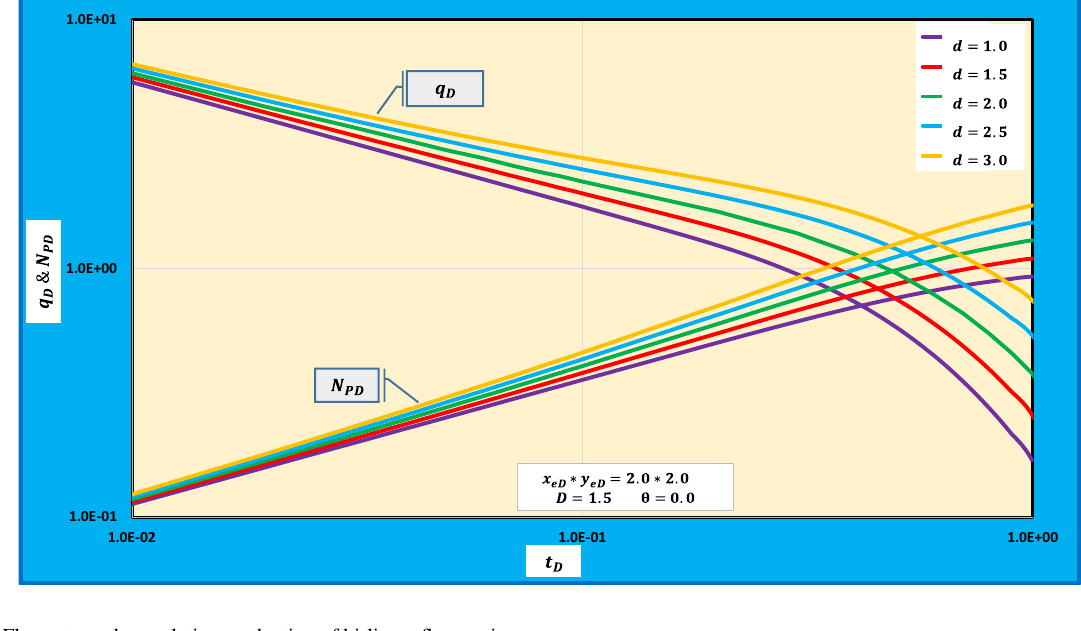
Fig. 22 Flow rate and cumulative production of bi-linear flow regime